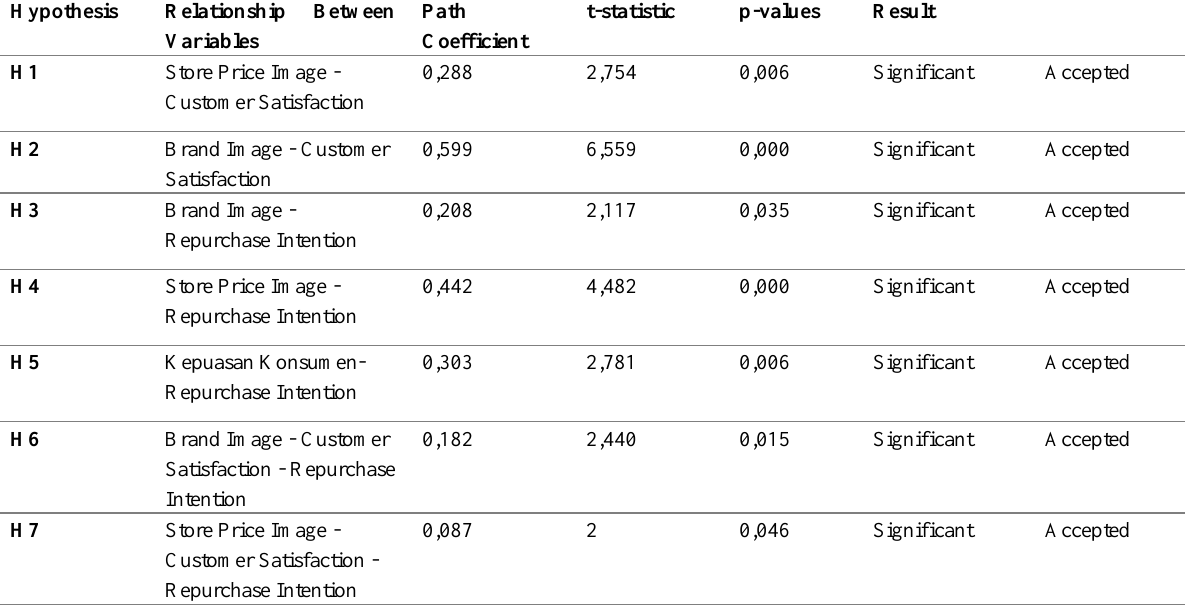
Table 2: Results of Direct Effect Hypothesizes